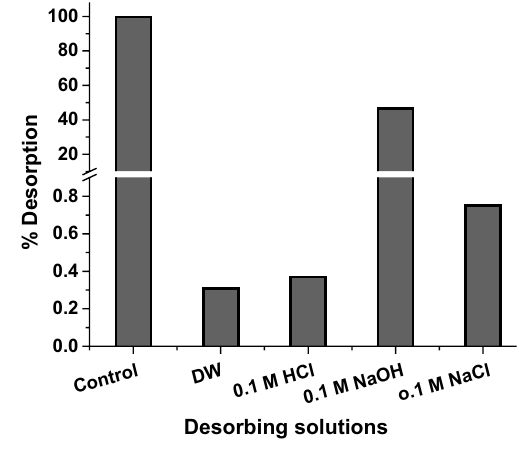
Fig. 11 Desorption of EB (dye-loaded SB—100 mg; dye concen- tration—100 mg/L; desorbing solutions − 25 ml; agitation time— 30 min)